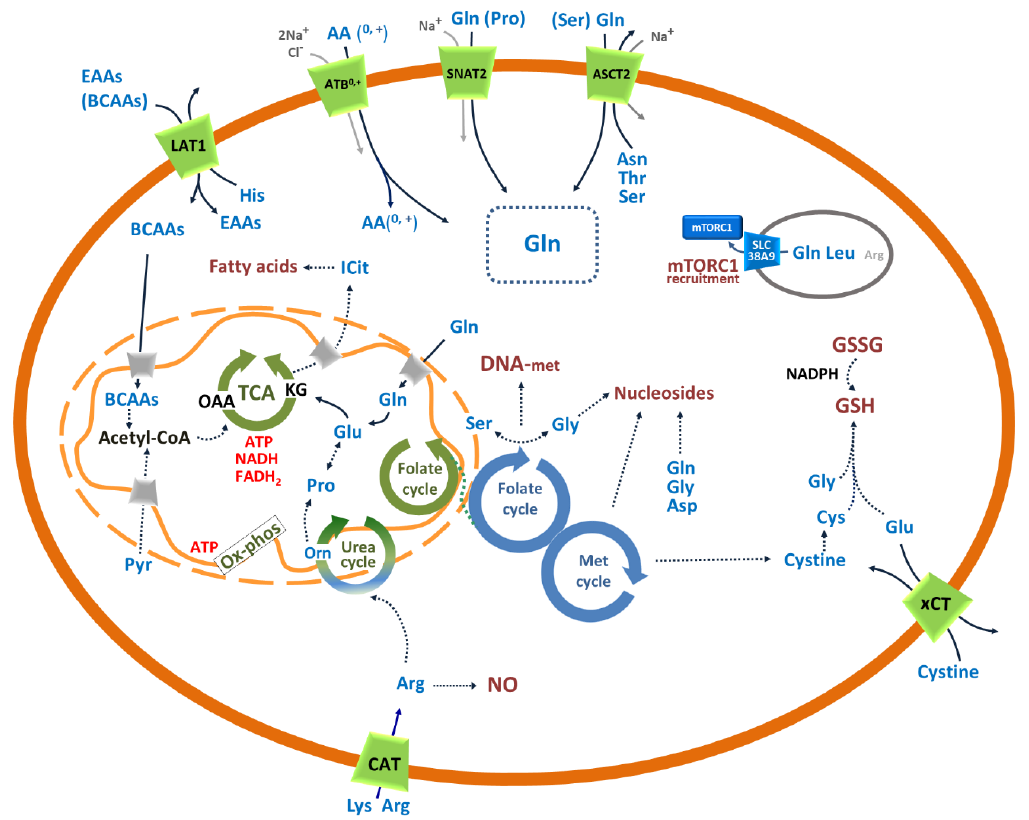
Figure 2. Schematic representation of specific pathways involved in changes of amino acid transport and metabolism occurring in cancer cells. Plasma membrane, mitochondrial or lysosomal transporters are represented by green, gray or blue trapezoids, respectively. The transporters known to be crucial for cancer metabolism are named by their common names (see the main text); in brief from the top left to the bottom right: LAT1 mediates the exchange of nine EAAs in a Na + independent mechanism and can be considered an harmonizer; ATB 0, + mediates the uptake of 18 out of 20 amino acids (AA 0, + ) with a Na + and Cl − dependent mechanism and can be considered a concentrative transporter; SNAT2 mediates the uptake mainly of Gln and Pro with a Na + dependent mechanism and can be considered a concentrative transporter; ASCT2 mediates the exchange mainly of Gln and Ser with other neutral amino acids with a Na + dependent mechanism and can be considered at a crossroad between concentrative transporter and harmonizer; SLC38A9 mediates the e ffl ux of Gln and Leu, regulated by Arg, from lysosomes and is considered a “transceptor”; CAT generically indicates CAT1, CAT2 and CAT3 that mediate the uptake of Lys and Arg; xCT mediates the exchange of Glu and cysteine. Transport and enzyme reactions are represented by continuous arrows; enzyme or transport pathways are represented by dotted arrows. Mitochondrial or cytosolic cyclic pathways are depicted in green or blue, respectively; the urea cycle which is partly mitochondrial and partly cytosolic is depicted in the two colors. Amino acids are represented by the three letter codes and are depicted in blue except for the lysosomal (gray membrane) arginine, which is in gray indicating a lower involvement in mTORC1 recruitment; non-amino acid intermediates are depicted in black, energetic substrates are depicted in red, biosynthetic or signaling processes are depicted in dark red. The cellular glutamine pool is in a dotted box. DNA methylation (DNA-met); oxidized / reduced glutathione couple (GSSG / GSH); oxoglutarate (KG); oxaloacetate (OAA); branched chain amino acids (BCAAs); essential amino acids (EAA); all neutral and cationic amino acids AA( 0, + ); isocitrate (ICit); CAT stands for the CAT1,2 and 3 isoforms of transporters.